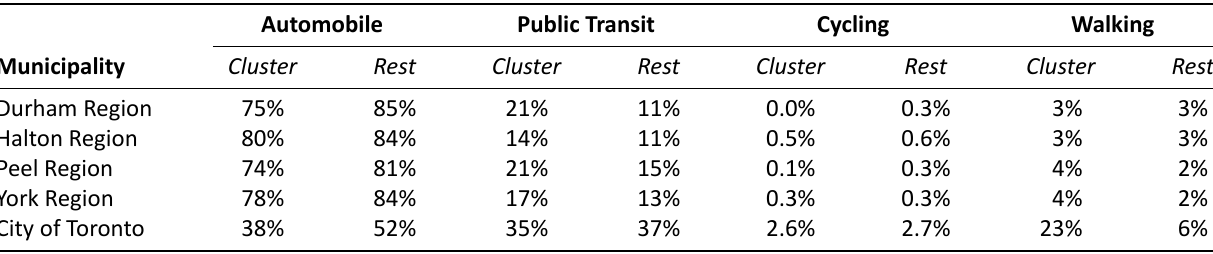
Table 2. Commute mode in new high-rise condo clusters vs. rest of the municipality. Source: authors’ calculations using 2016 Statistics Canada DA